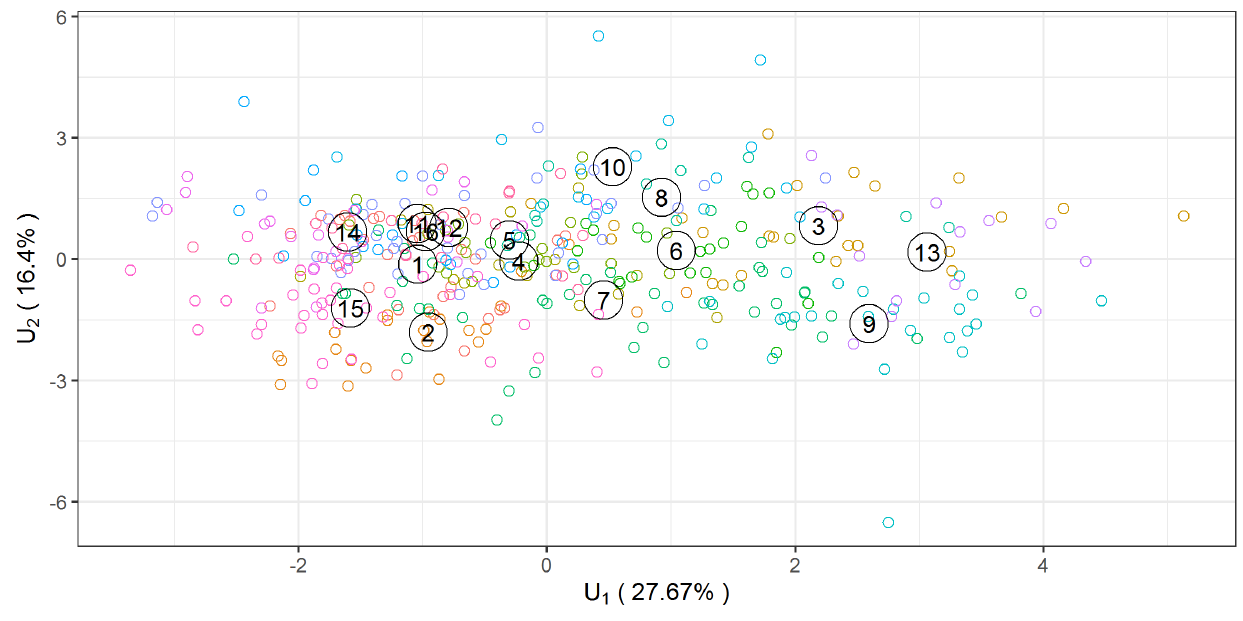
Figure 3. Plotted values of the first two functional discriminant